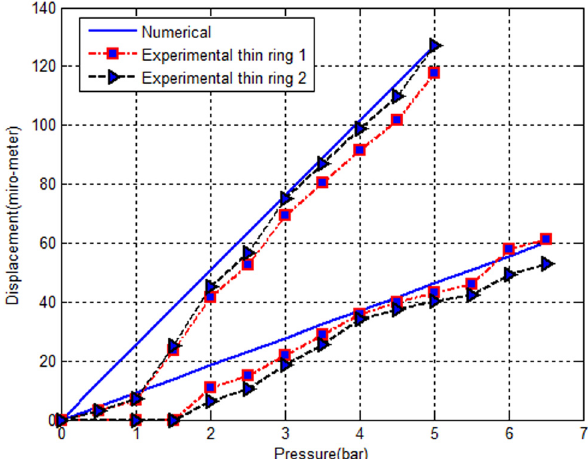
Figure 5: Evolution of radial displacement of the mid - surface according to the